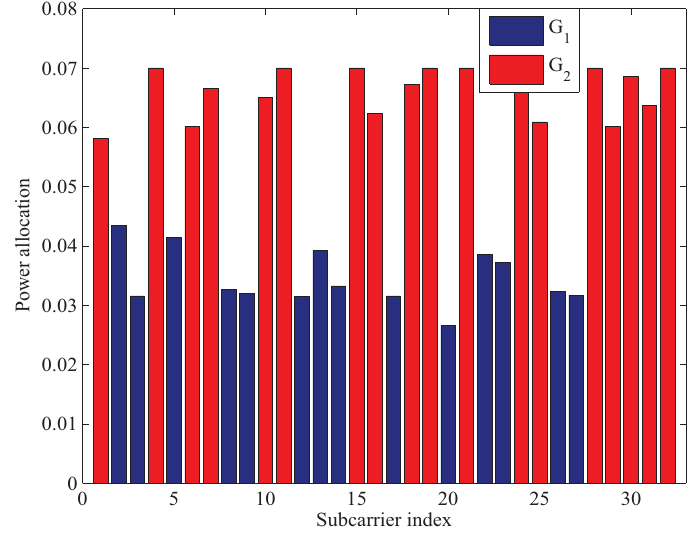
Figure 5. Power and subcarrier allocation in the second